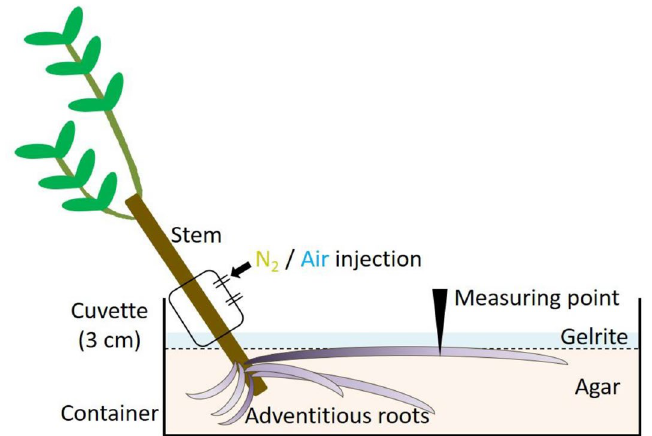
Figure 7. Diagram of how oxygen partial pressure was measured in adventitious roots. Root systems were fixed in containers if deoxygenated solid agar (1.5% w/v) at the same water level at which they were grown in hydroponic or agar media. The target adventitious roots were fixed near the surface of the solid agar and covered with deoxygenated solid gelrite (2% w/v). Air or N 2 was injected through a cuvette that covered the stem. Positioning of the microelectrode inside the root was aided with a microscope and adjusted with a boom